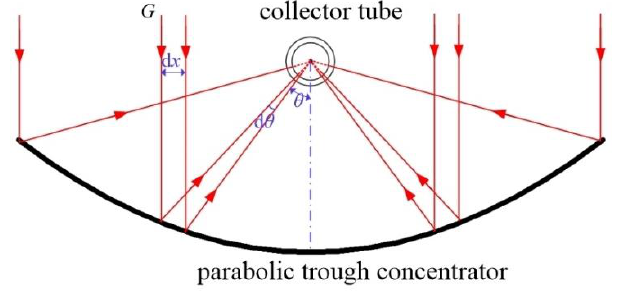
Figure 1. Schematic diagram of the cross section of a parabolic trough concentrating solar